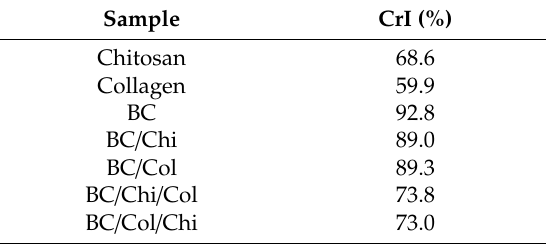
Figure 4. X-Ray di ff raction patterns of ( a ) chitosan, ( b ) collagen, ( c ) BC, ( d ) BC / Chi, ( e ) BC / Col, ( f ) BC / Chi / Col, and ( g ) BC / Col / Chi. Table 2. Crystanillity index (CrI) data of chitosan, collagen, BC, BC / Chi, BC / Col, BC / Chi / Col, and BC / Col /